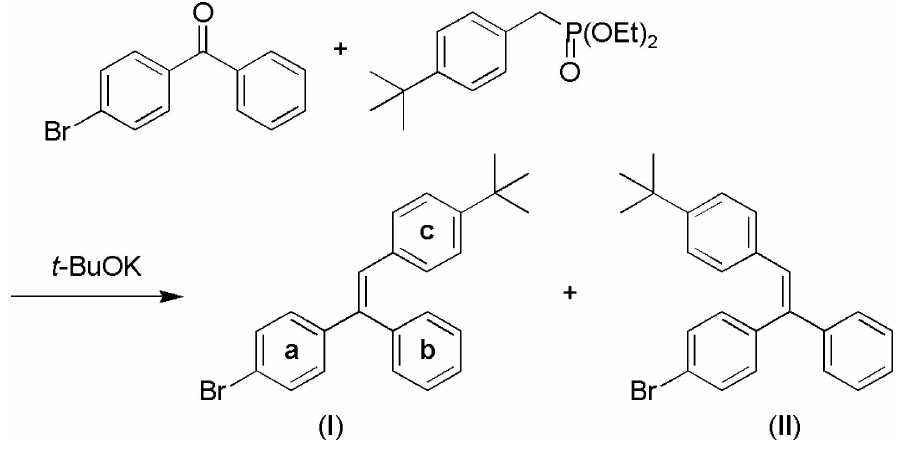
Figure 2 Reaction